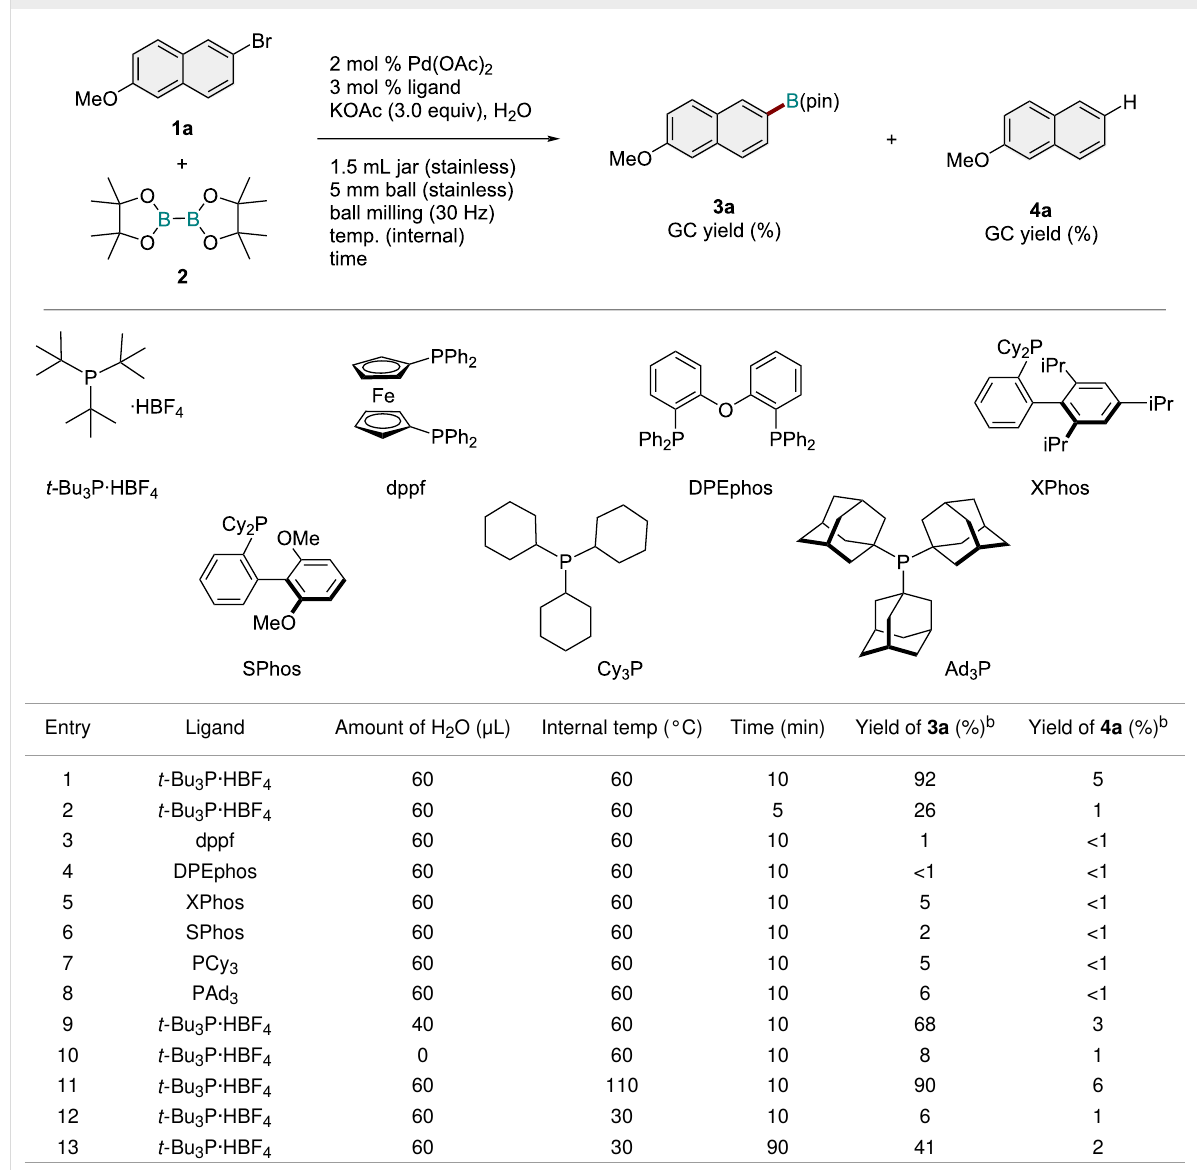
Table 1: Optimization of the reaction conditions.